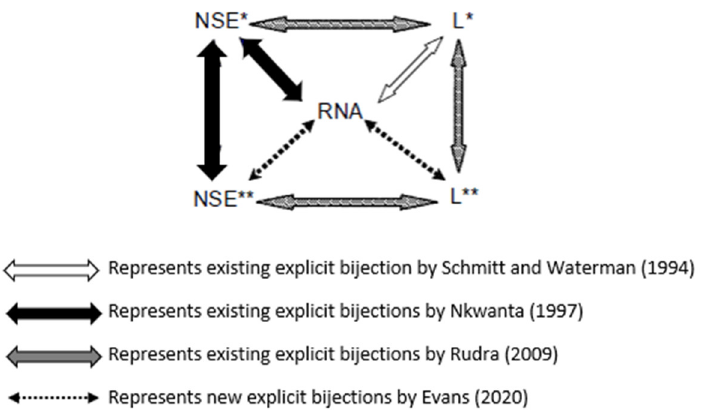
Figure 4. Refs. [18,19,24,25] Connections among linear trees, lattice walks, and RNA secondary structures.